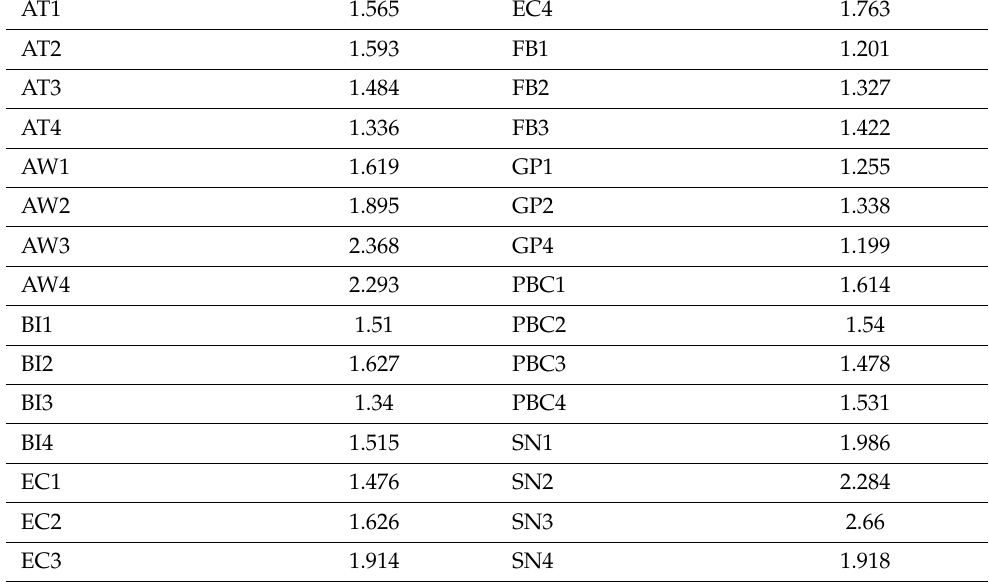
Table 6. VIF (Variance Inflation Factor).